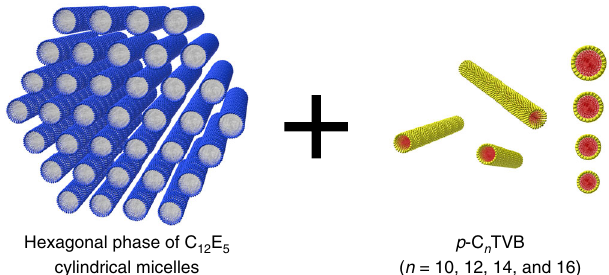
Fig. 2 Mixing of two types of 1D nano-objects. The cylindrical nanoparticles ( p -C n TVB, right ) are added into the hexagonally packed C 12 E 5 cylindrical micellar system ( left )